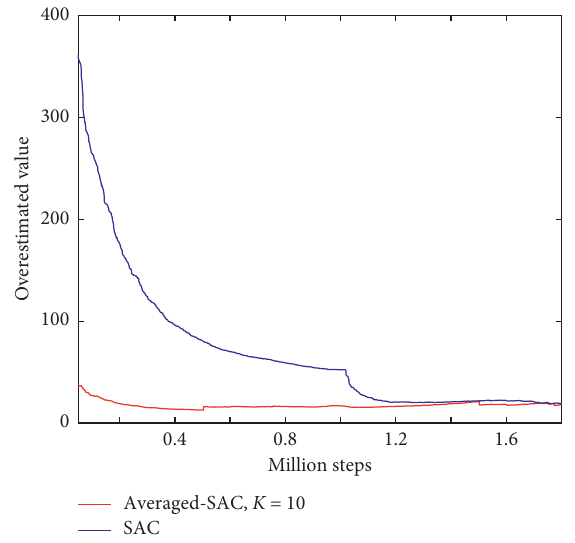
Figure 1: Results of the overestimation of Averaged-SAC and